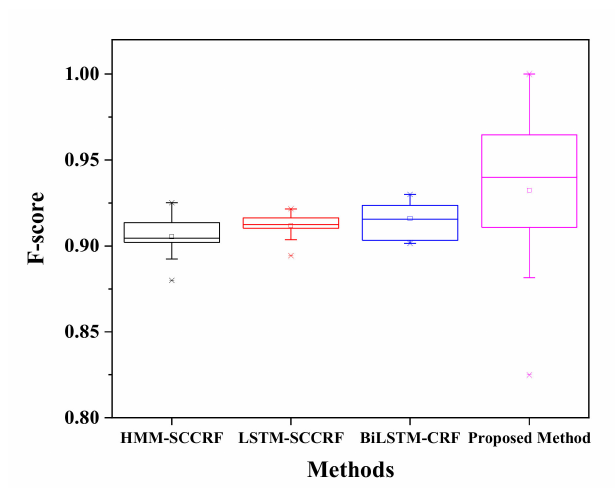
Figure 11. F-score comparison on